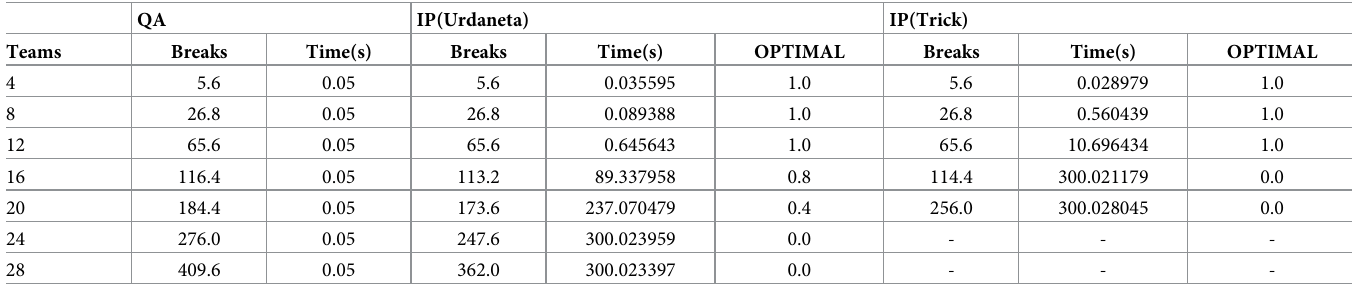
Table 7. QA vs. IP in